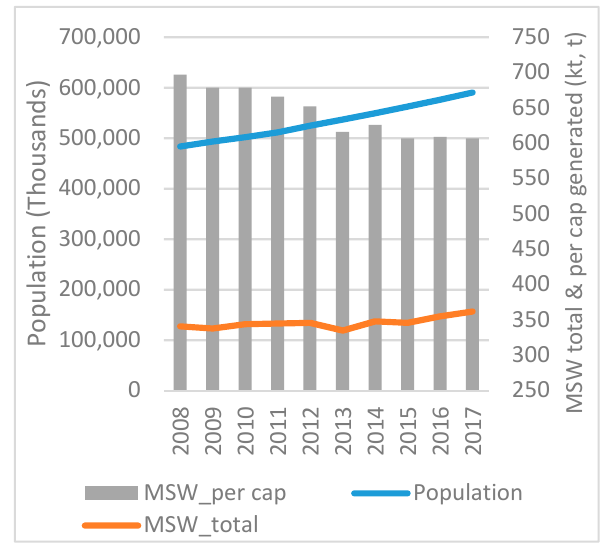
Figure 31. Population and MSW production in Luxembourg 2008–2017 (EUROSTAT 2019a, 2019c).